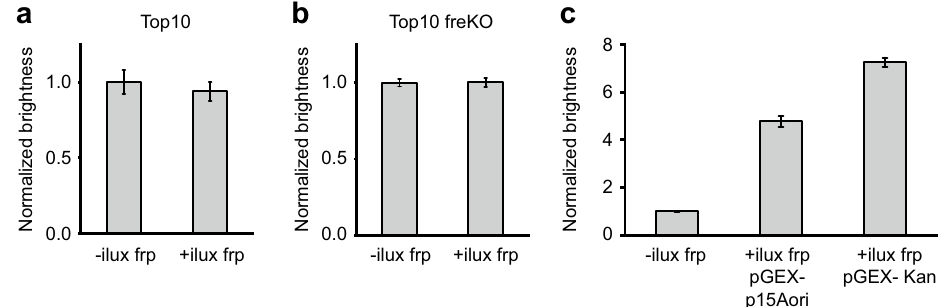
Figure 5. Mutagenesis and screening of ilux frp . Plots show the relative bioluminescence signal normalized to iluxCDABE without frp . ( a ) Relative brightness of iluxCDABE expressed from pGEX(−) Kan with the empty vector pGEX(−) lac p15Aori (left) and with additional expression of ilux frp from pGEX(−) lac p15Aori (right) in Top10 cells. ( b ) Relative brightness of iluxCDABE expressed from pGEX(−) Kan with the empty vector pGEX(−) lac p15Aori (left) and with additional expression of ilux frp from pGEX(−) lac p15Aori (right) in a Top10 fre knockout (freKO) strain. ( c ) Relative brightness of iluxCDABE pGEX(−) Kan in the Top10 freKO strain without additional expression of ilux frp (i.e., with the empty vector pGEX(−) p15Aori) (left), with additional expression of ilux frp from pGEX(−) p15Aori (middle) and with additional expression of ilux frp from the same vector pGEX(−) Kan (right). For mutagenesis of ilux frp , expression from pGEX(−) p15Aori (together with iluxCDABE from pGEX(−) Kan) was chosen due to the sufficiently increased brightness compared to cellular FMNH 2 production only. Error bars represent SD of 10 different